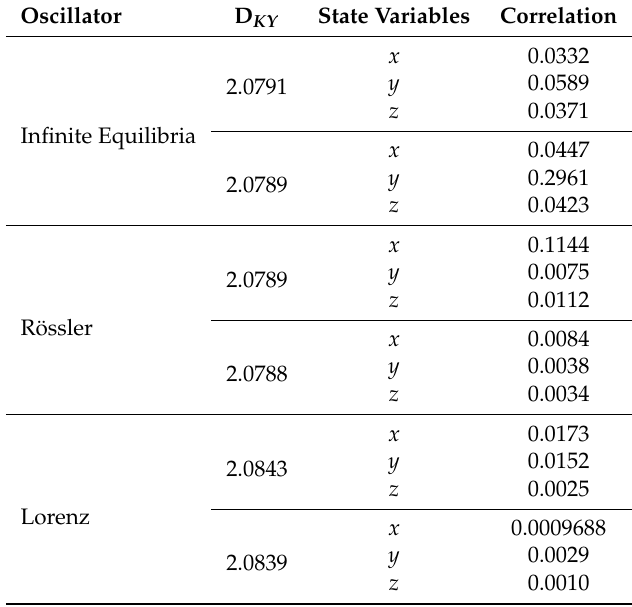
Table 5. Correlation between the original image and the chaotic channel using each state variable of the two highest D KY of each chaotic